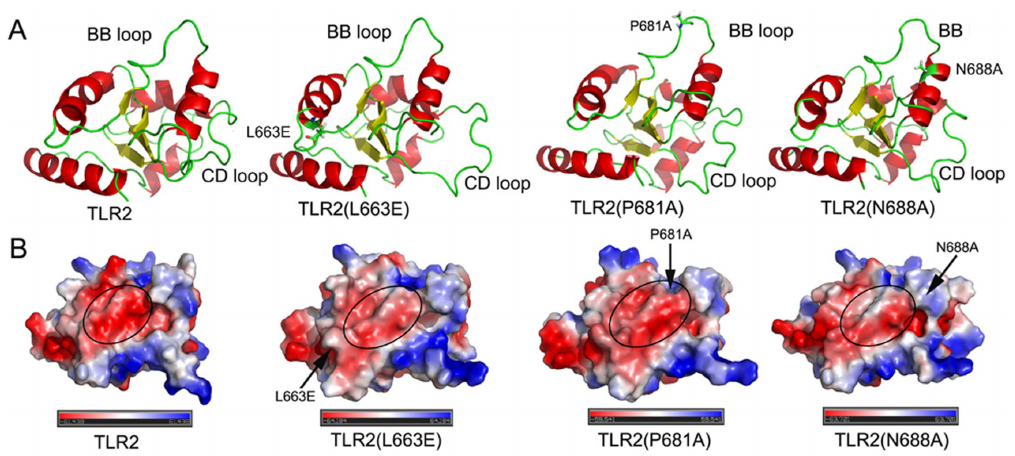
Figure 6. Electrostatic charge and conformation of the BB and CD loop were compared between wild-type TLR2 and its mutants. A, the conformation of the BB and CD loop in wild-type TLR2, TLR2 (L663E), TLR2 (P681A) and TLR2 (N688A) was compared, and the mutated residues L663E, P681A and N688A were stick represented. B, comparison of the electrostatic surfaces of wild-type TLR2, TLR2 (L663E), TLR2 (P681A) and TLR2 (N688A), the change of positive charge ( blue ) and negative charge ( red ) in the BB loop was indicated by a circle, and the mutated residues L663E, P681A and N688A were indicated by an arrow.